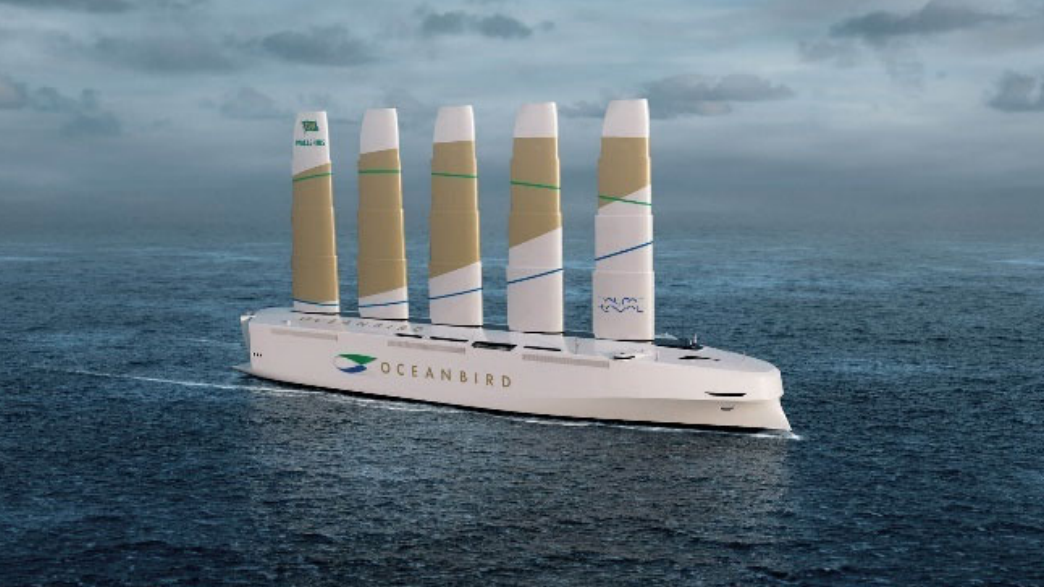
Figure 7. The Oceanbird design is based on a car carrier that can transport up to 7000 vehicles. Besides reducing air emissions, Oceanbird will also decrease sound pollution in the water. (Copy- right Oceanbird).